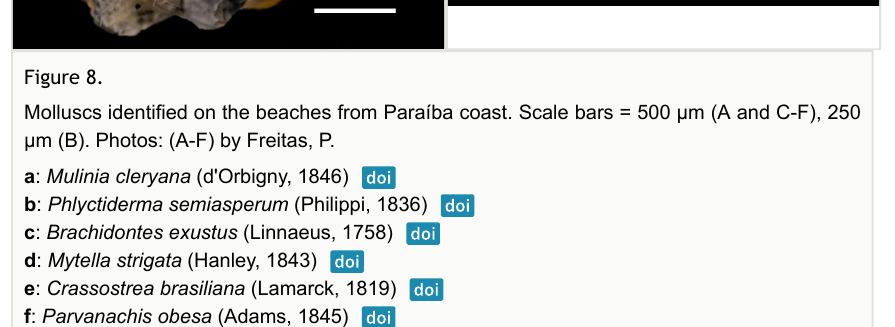
Diagnosis: (Signorelli 2019): Shells trigonal, inflated, umbos placed about half shell length, inflated and prosogyrate; external surface smooth; postero-dorsal area defined by a distinct keel-like carina; anterior and posterior ends low and well defined (Fig. 8a). Ventral margin sinuous; right hinge with two anterior and two posterior lateral teeth, being the ventral more elongated, two divergent and unfused cardinal teeth; left hinge with the usual V-shaped cardinal tooth, flanked by an accessory lamella, one anterior